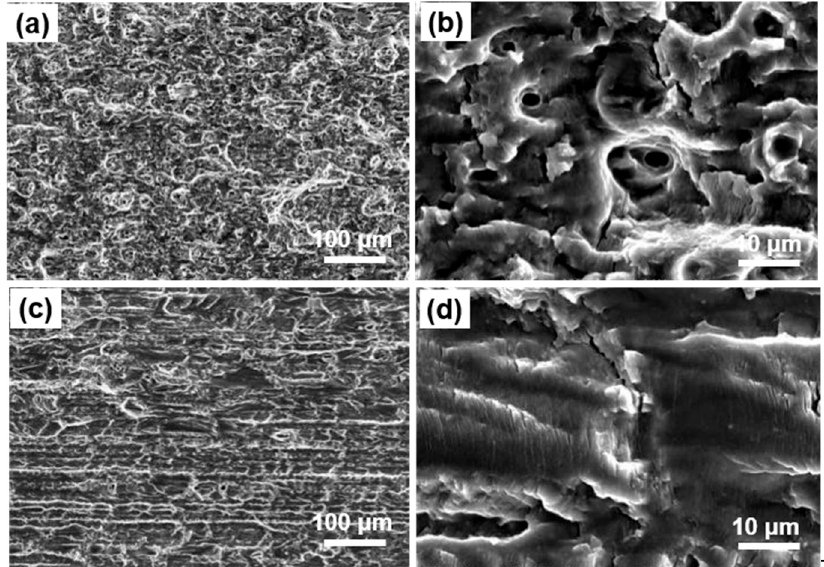
Figure 7. SEM fractography of Al-Cu-Li-Mg-Zr alloys upon a value of ∆ K at 10 MPa · m 1/2 . The mi- crographs collected at ( a , c ) a lower magnification and ( b , d ) a higher magnification for ( a , b ) High Fe and ( c , d ) Low Fe alloys.